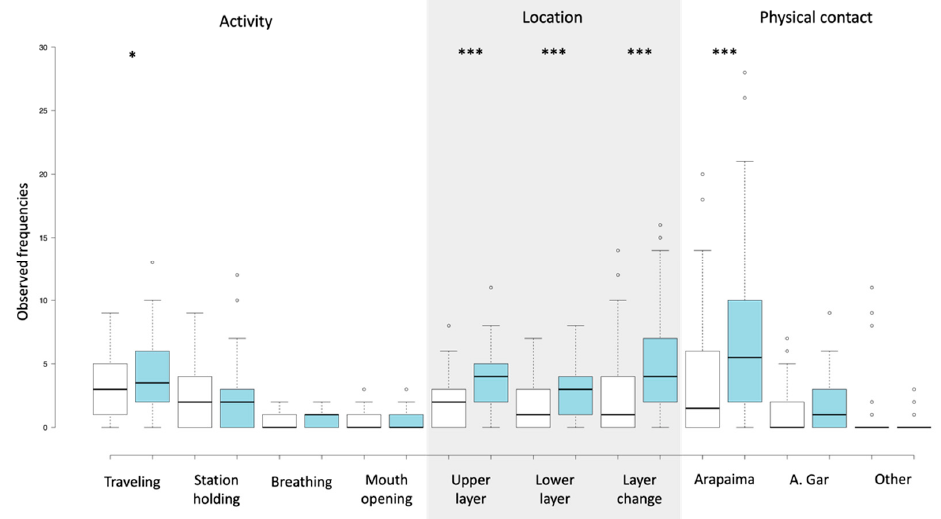
Figure 3. The observed frequency of the ten monitored behaviours during the test (blue) and baseline (white) conditions. Boxplots represent the median and interquartile range (IQR) with whiskers indicating the top and bottom 5% of occurrences and outliers are represented by the circles. Significant change between baseline and test conditions is marked with asterisks (* p > 0.05, *** p > 0.001).